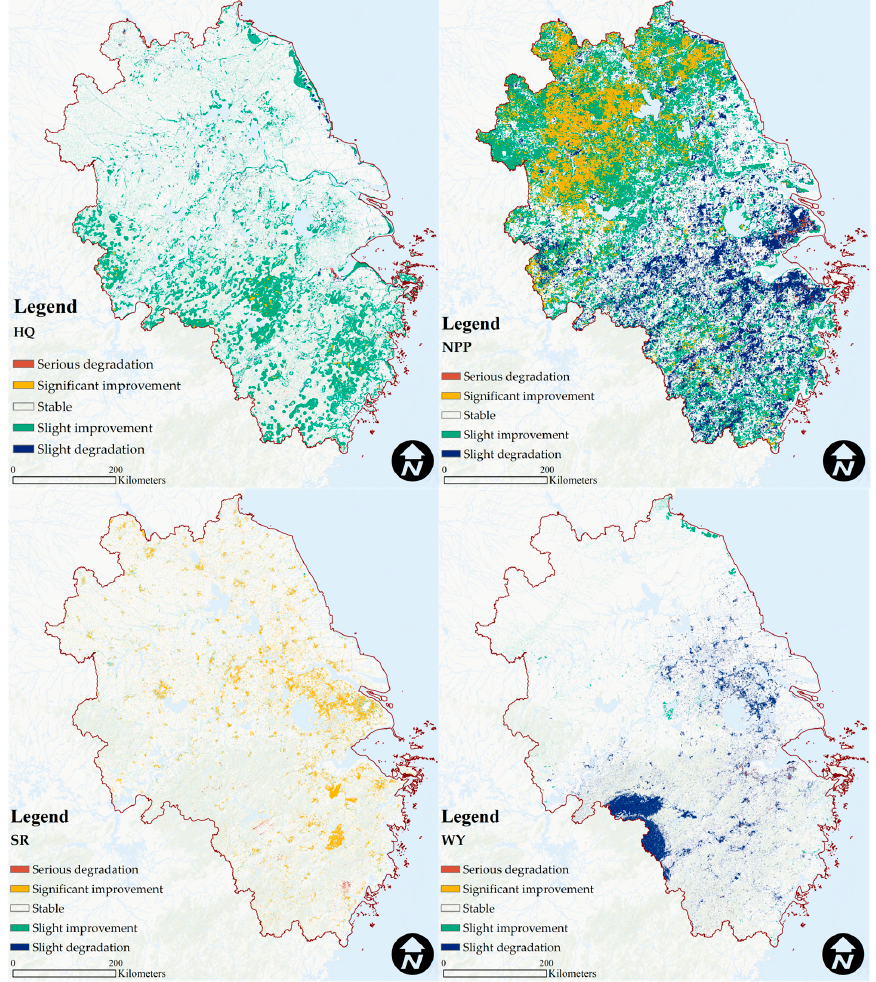
Figure 7. Analysis of the change in types of ecosystem services in the Yangtze River Delta from 1980 to 2020. Table 3. Trends in the ecological system of the Yang tz e River Delta urban agglomeration from 1980 to 2020.